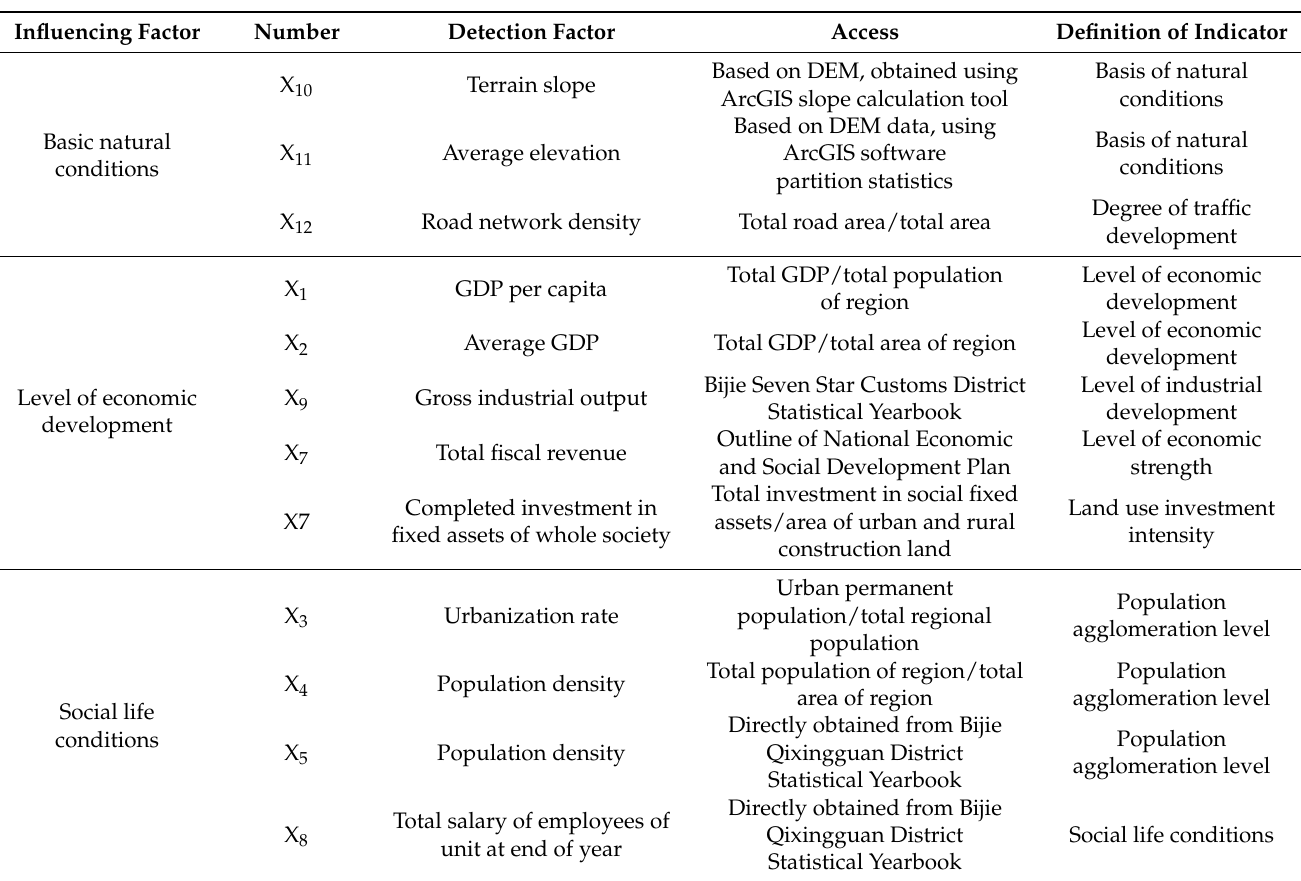
Table 1. Detection indicators of influencing factors of urban–rural construction land